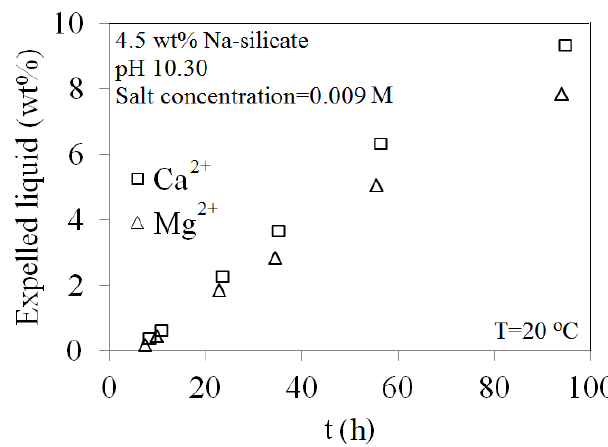
Figure 27. Weight percent of the expelled liquid as a function of time for 4.5 wt% Na-silicate solution with pH 10.30 at 20 °C. A comparison is made for 0.009 M solutions of CaCl and MgCl 2